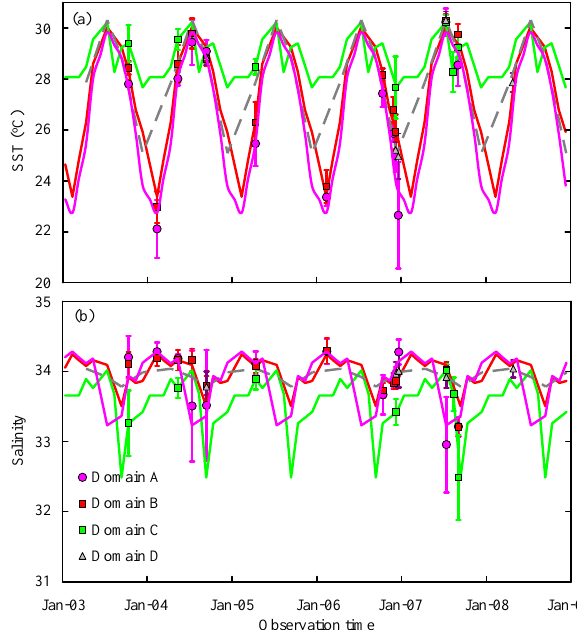
Fig. 3. Seasonal variations of sea surface temperature (SST) (a) and salinity (b) in domain A (pink curves), in domain B (red curves), in domain C (emerald green curves), and in domain D (grey dashed curves) based on data presented in Tables 3, 4, 5, and 6. Real data are shown as mean ± standard